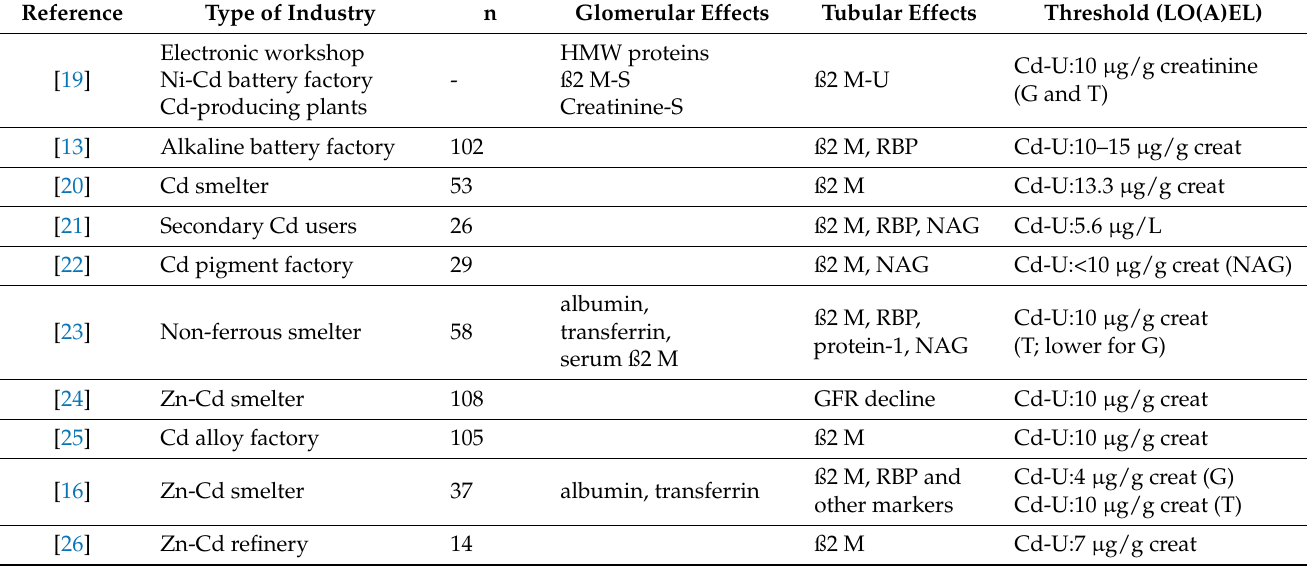
Table 1. Thresholds for renal effects in studies in occupational settings (adapted from SCOEL 2017-SCOEL/OPIN/336)